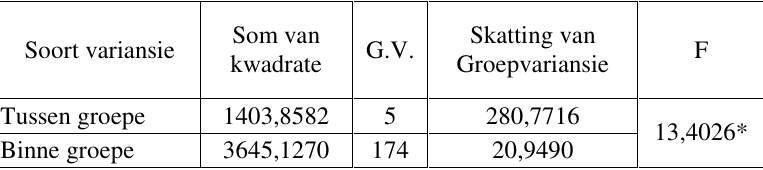
Uit Tabe1 22 blyk dat daar beduidende verskille tussen 1aboratoriums bestaan ten opsigte van gelyke luidheidswaardes wat teen die 75 dB verwysingspeil gevind is (p<,01). Hierdie beduidende verskille word verder ontleed deur die Scheffé (1959) metode en in Tabel 23 uiteengesit: